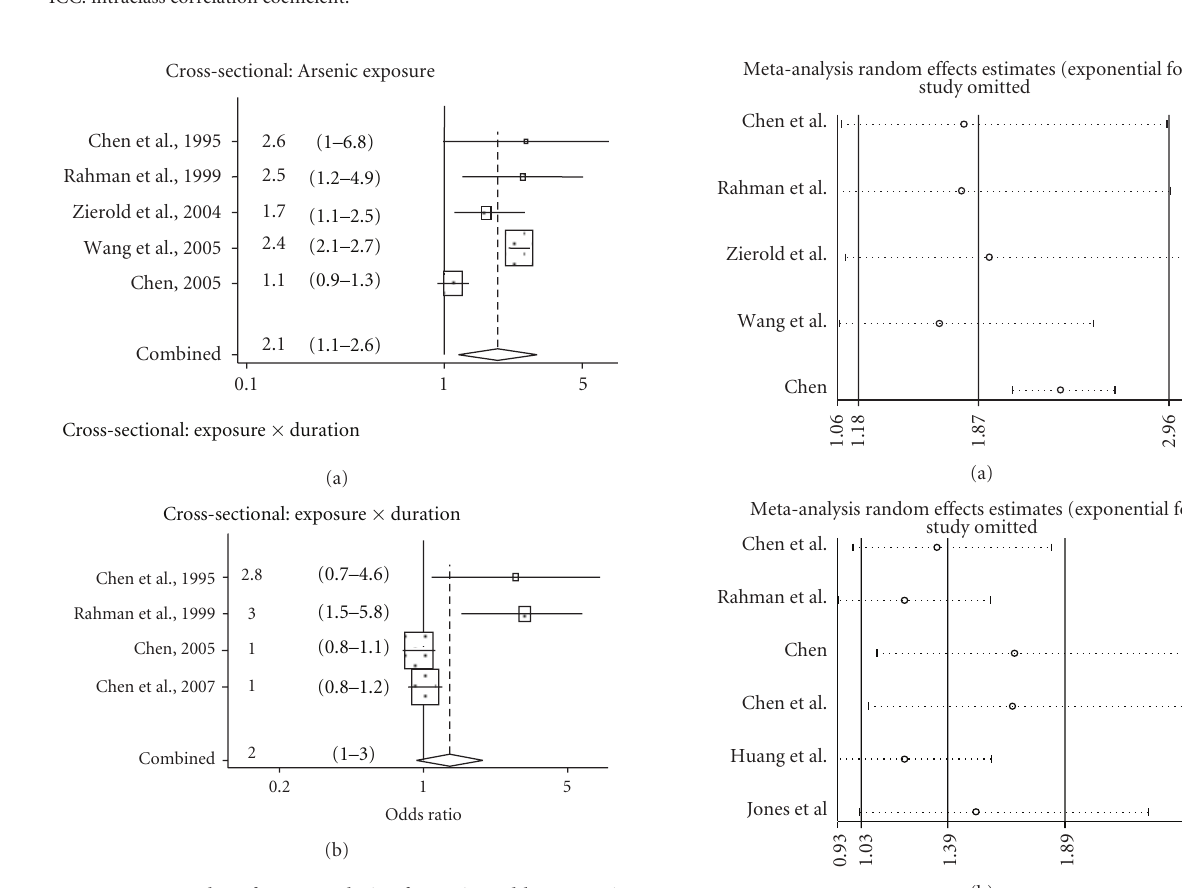
Figure 1: Forest plot of meta-analysis of arsenic and hypertension in cohort and cross-sectional studies.